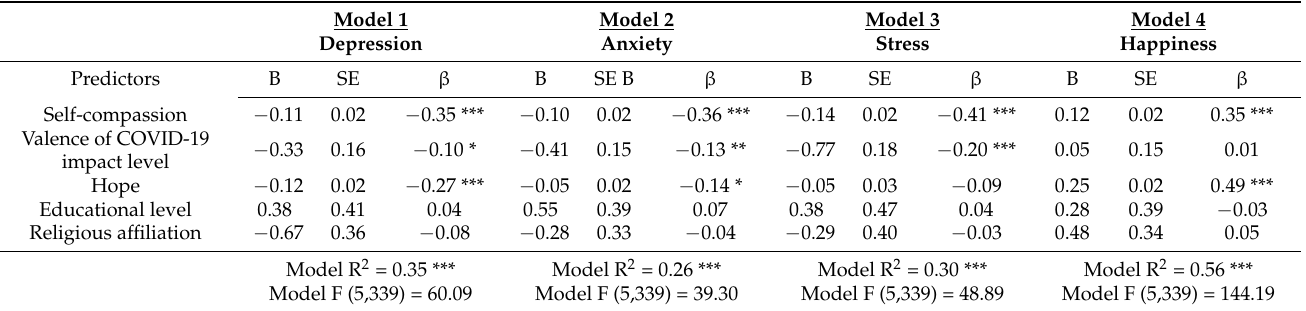
Table 4. Summary of regression analysis for prediction of mental